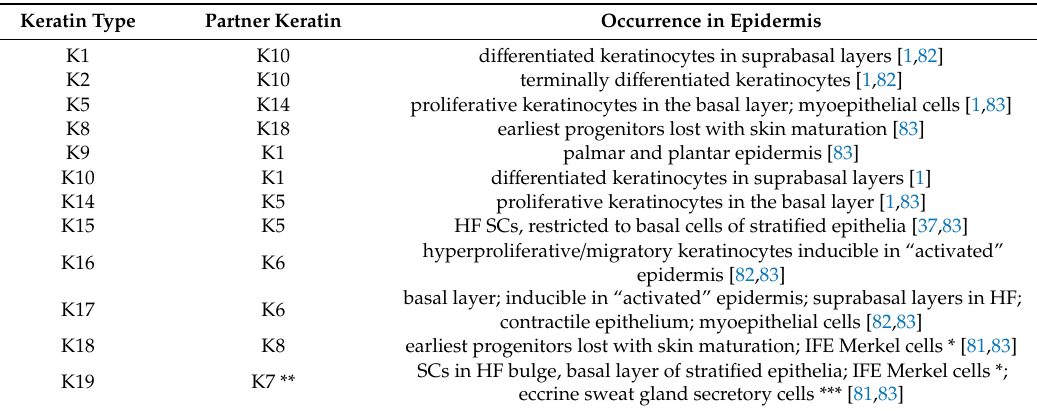
Table 1. Epidermal